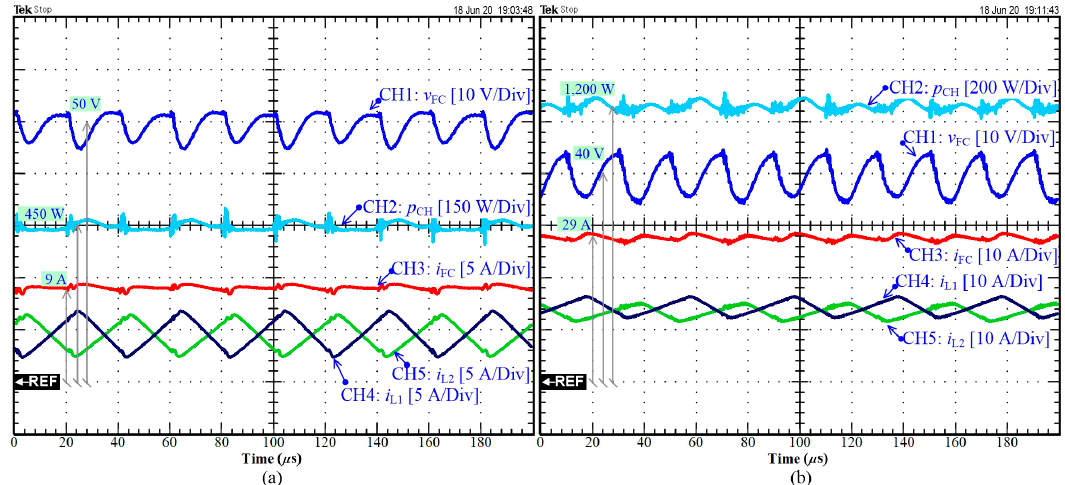
Figure 9. Experimental results: Signal waveforms of the FC converter: ( a ) at CPL = 450 W, ( b ) at CPL = 1200 W.